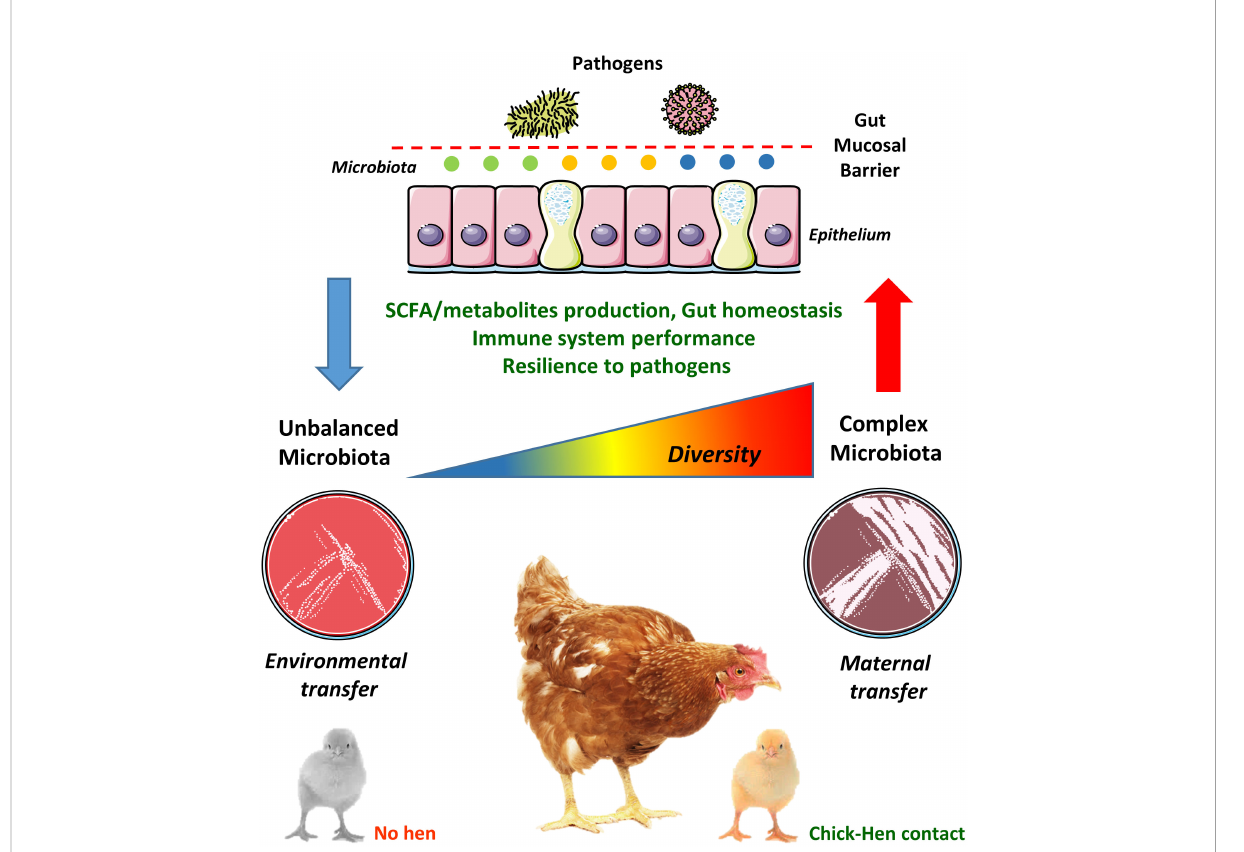
FIGURE 1 Chick-hen contact in fl uences microbiota acquisition and diversity in early life. The gut microbiota (GM) is usually transmitted vertically from mothers to newborns, where pioneer colonizers (i.e. the fi rst bacteria reaching the neonatal gut) greatly in fl uence the development of a complex microbiome. However, the current commercial poultry production systems, with its high-standard hygiene procedures, has eliminated any contact between hens and chicks. Therefore, chicks are colonized by microbes present in the environment, feed and transferred by human contact, which often hampers the establishment of a diverse and well-balanced GM in early life. This may lead to negative consequences to gut physiology and homeostasis, such as altered short-chain fatty acids (SCFA) and metabolites production, dysfunctional gut mucosal barrier, reduced immune system performance and increased susceptibility to pathogens. These alterations are probably not restricted to the gut environment and could impact remote mucosal sites such as the lungs (the gut-lung